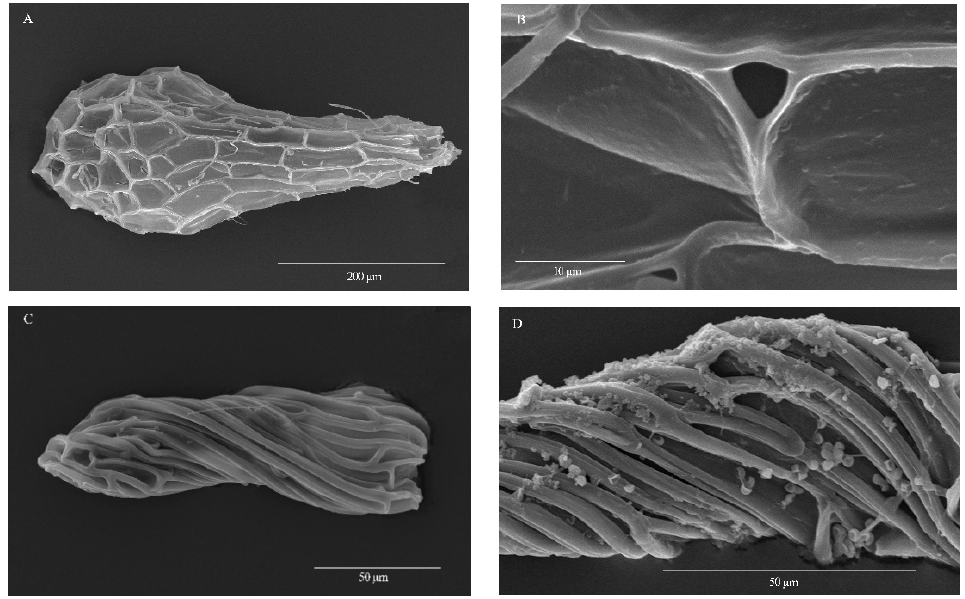
Figure 2. Seed morphology under SEM: ( A ) seed and cell shapes in B. finlaysoniana ; ( B ) intercellular gaps in B. finlaysoniana ; ( C ) seed and cell shapes in B. cecieliae ; ( D ) medial cells and anticlinal zone in B. truncata . Table 3. Average values and standard deviation of quantitative data in the seeds of the studied species of Bromheadia : seed length (SL), seed width (SW), number of cells (NC), medial cell angle (MCA), embryo length (EL), embryo width (EW), seed volume (SV), embryo volume (EV), percentage of free air space, distance to the apical pole (DAP), distance to the basal pole (DBP), lateral distance (LD), seed mass (SM). The seed and embryo volumes, and the percentage of free air space were calculated following the described method